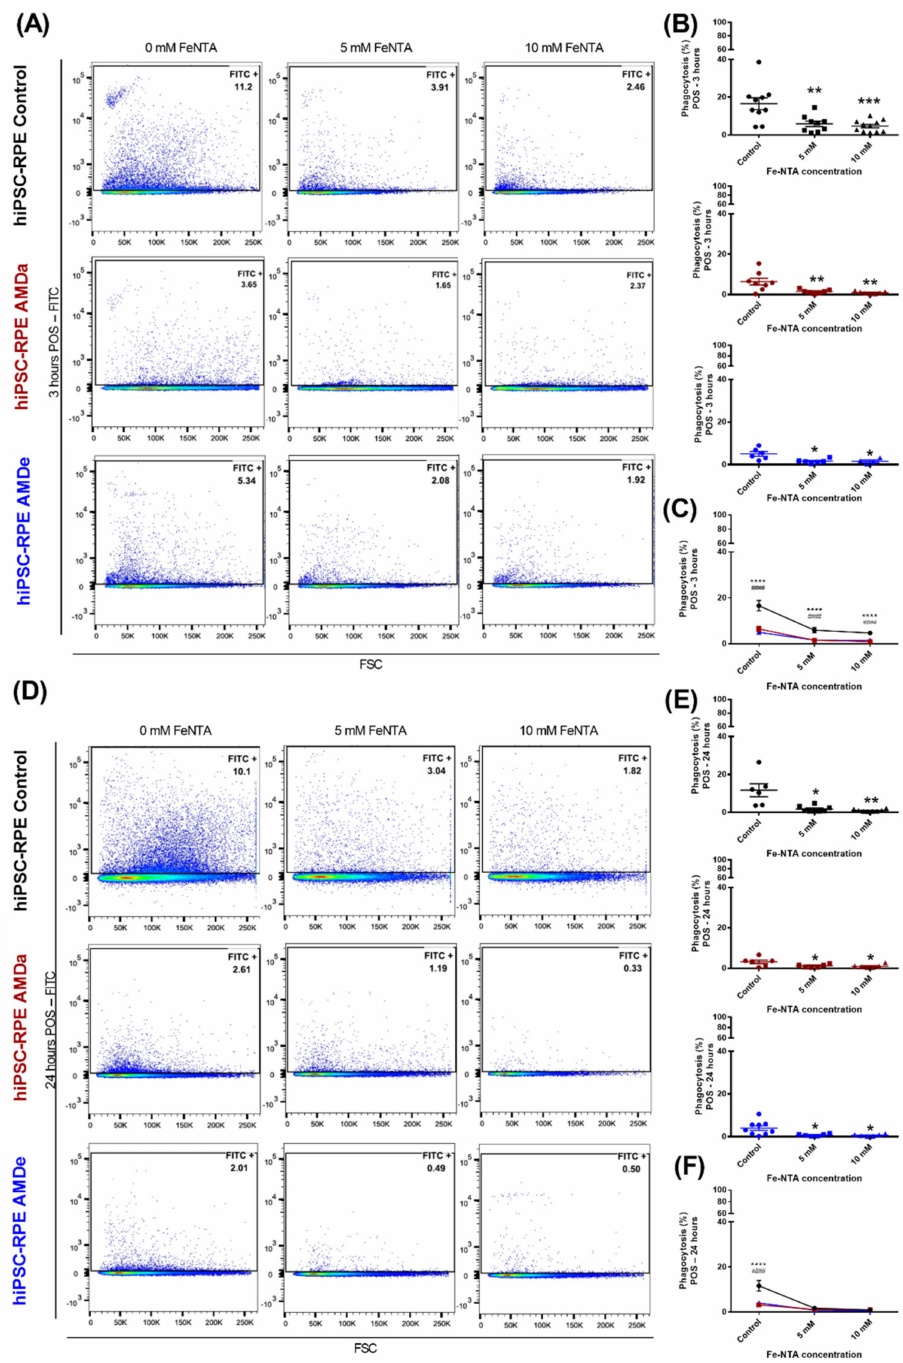
Figure 3. Specific phagocytosis function of hiPSC RPE Control and AMDa/e cell lines in oxidative stress condition induced by Fe-NTA. Flow cytometry analysis ( A , D ) and quantification ( B , C , E , F ) of 3 h POS challenged and 24 h POS challenged of hiPSC RPE Control (N = 5, n = 2), AMDa (N = 6, n = 2) and AMDe (N = 3, n = 2) cells in 24 h oxidative stress condition induced by different Fe- NTA concentrations). For C and F, comparison between hiPSC Control and AMDa (*) or AMDe (#). Statistical analysis: Kruskal–Wallis. * p < 0.05, ** p < 0.01, *** p < 0.001, **** , #### p <